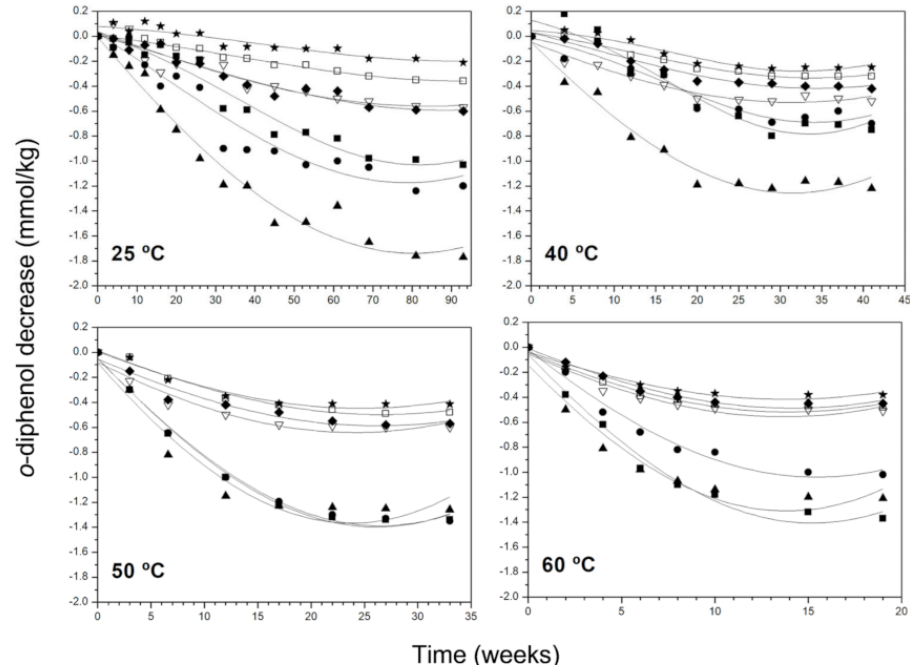
Figure 2. Decrease of o-diphenol content in VOO samples at 25, 40, 50 and 60 ◦ C. Samples: (cid:4) , I; • , II; (cid:78) , III; ∇ , IV; , V; (cid:3) , VI; (cid:70) ,